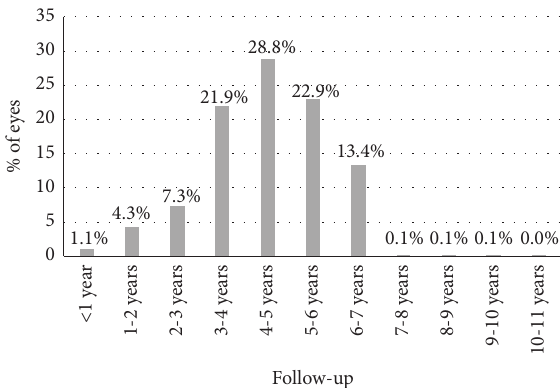
Figure 3: Distribution of the follow-up of cases enrolled in the current retrospective